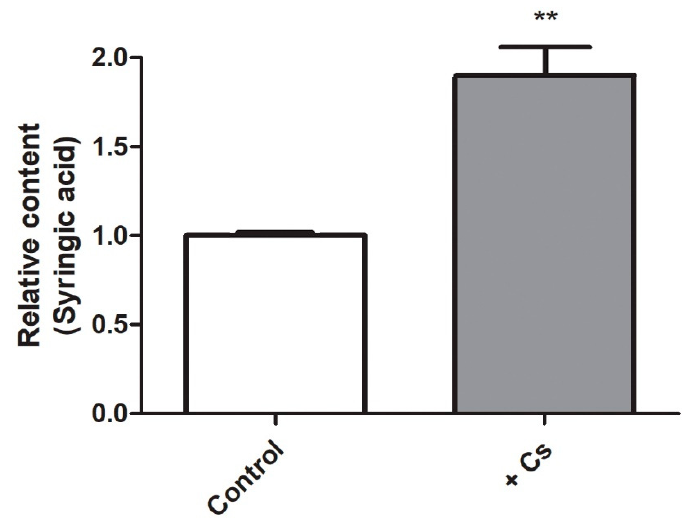
Figure 1. Relative levels of syringic acid in Arabidopsis . The levels of syringic acid were analyzed in shoots of cesium-treated Arabidopsis plants by liquid chromatography coupled with tandem quadrupole mass spectrometry (LC-QqQ-MS). Results are presented as a ratio between the level of syringic acid in untreated control plants versus the level in cesium-treated plants. The white bar indicates the level of syringic acid in shoots of control plants and the grey bar indicates the level of syringic acid in shoots of cesium-treated Arabidopsis plants. Error bars represent the standard error (SE). A t -test was conducted and ** indicates a significant difference between treated and untreated plants ( p < 0.01, n = 4).